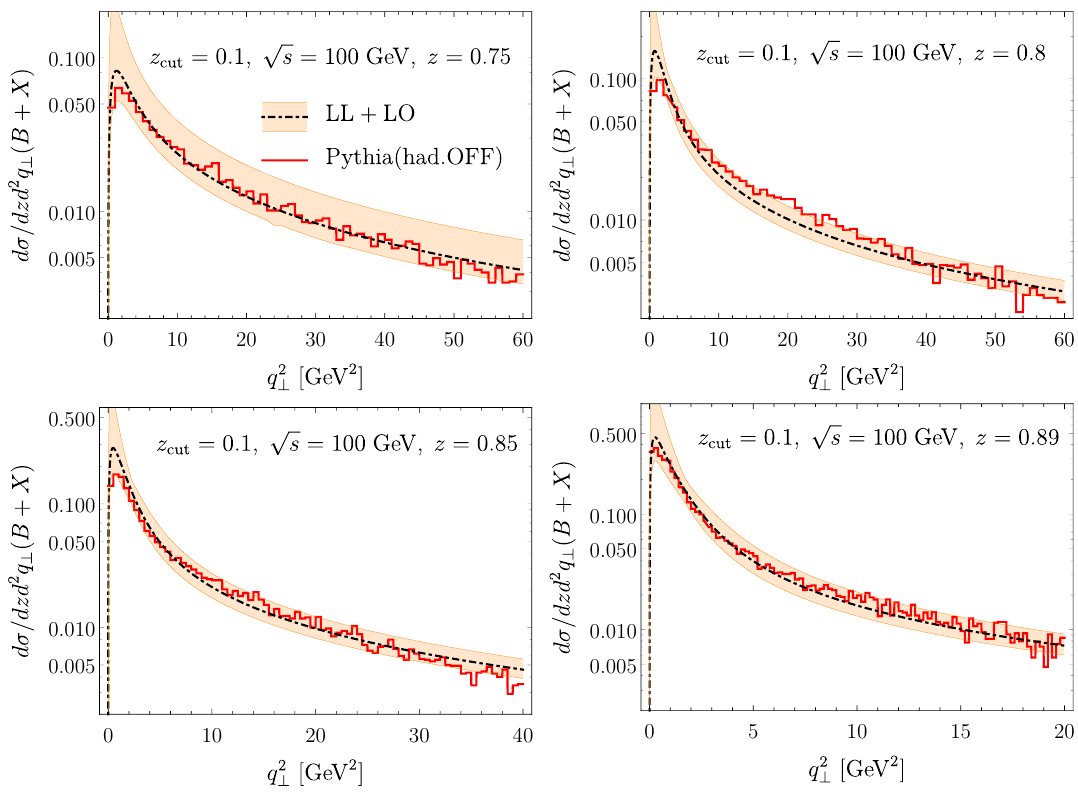
Figure 4 . Comparison of the analytical result(with error bands) at LL+LO accuracy with parton level Pythia with a jet energy E J = Q= 2